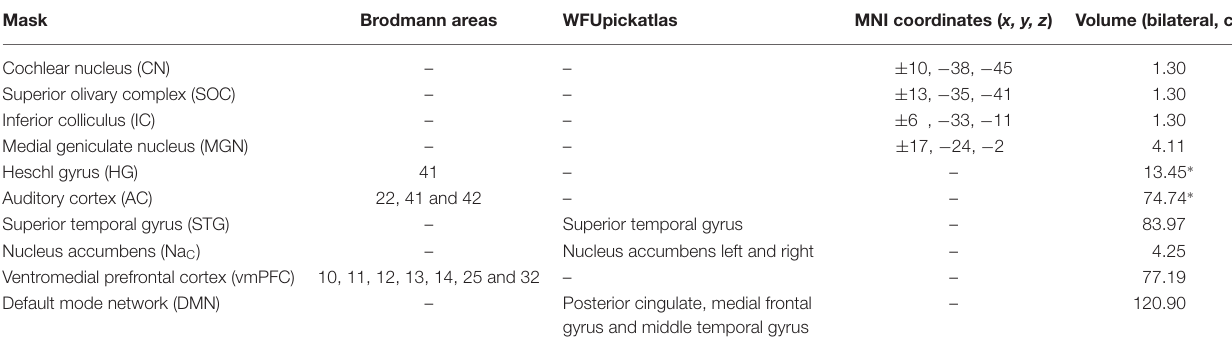
TABLE 2 | The definitions of the masks used and how they were defined.